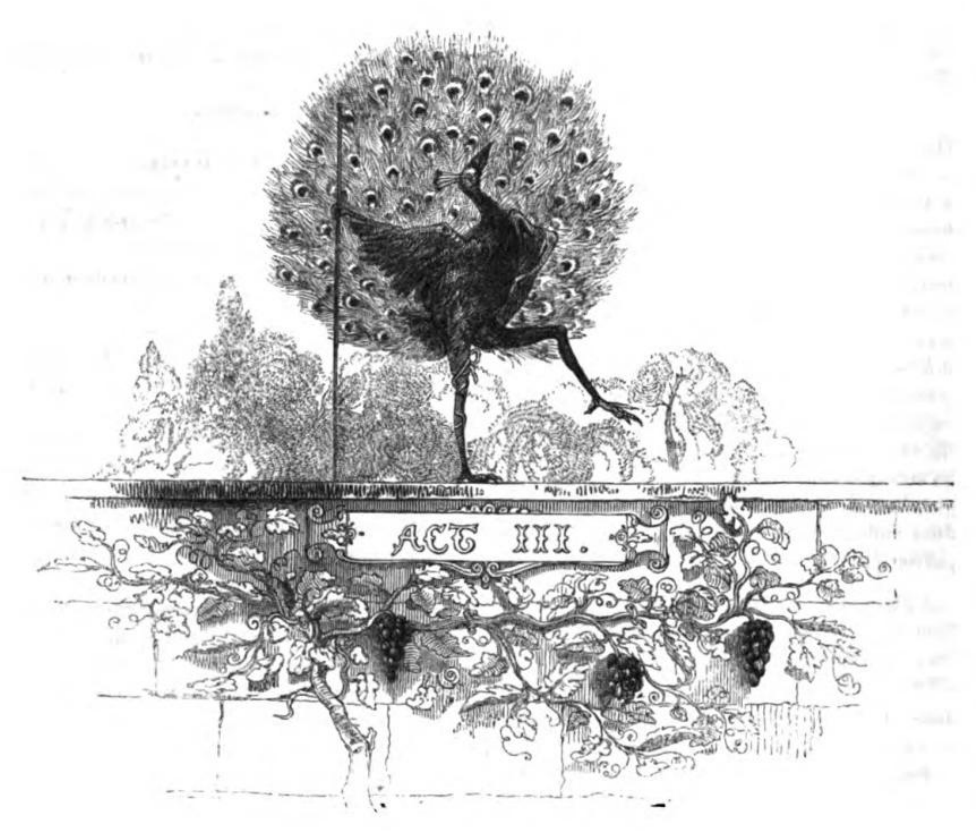
Figure 2. Engraving by Vizetelly Brothers from a drawing by Kenny Meadows, in The Works of